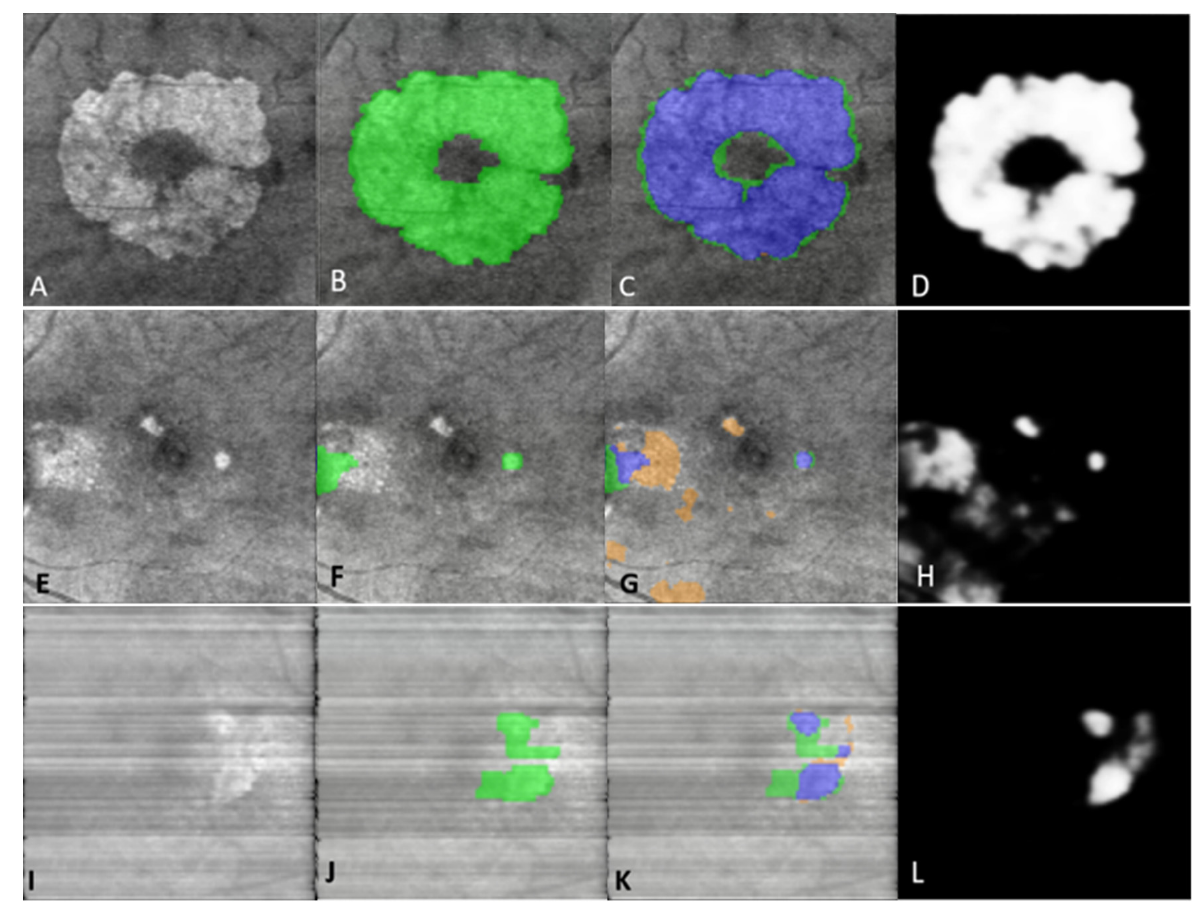
Figure 5. Left panel ( A – D ) shows en face model GA segmentation performance as visualized on en face OCT images. ( A ) Raw en face OCT image from a patient with GA; ( B ) Ground truth mask (indicated in green) generated using multi-layer segmentation and concurrence of EZ, RPE, and BM lines, and subsequent compilation of B-Scan masks for the whole volume; ( C ) en face model output overlay with blue areas indicating correct segmentation of GA area, orange areas indicating false positive segmentation for GA (but true positive of hypertransmission defects) and green areas indicating false negative segmentation; ( D ) Gray-scale output of the en face model indicating model confidence. Middle panel ( E – H ) shows an example of false positive segmentation. Right panel ( I – L ) shows an example of false negative segmentation. GA: Geographic Atrophy; EZ: Ellipsoid Zone; RPE: Retinal Pigment Epithelium; BM: Bruchs Membrane. Images A-C and E-G were captured using or Cirrus HD-OCT (Zeiss, Oberkochen, Germany) with the 512 × 128 imaging protocol for 6 × 6 mm macular cubes. Images I-K were Captured using Spectralis HRA + OCT (Heidelberg Engineering, Heidelberg, Germany) with the 97 B-scan macular cube